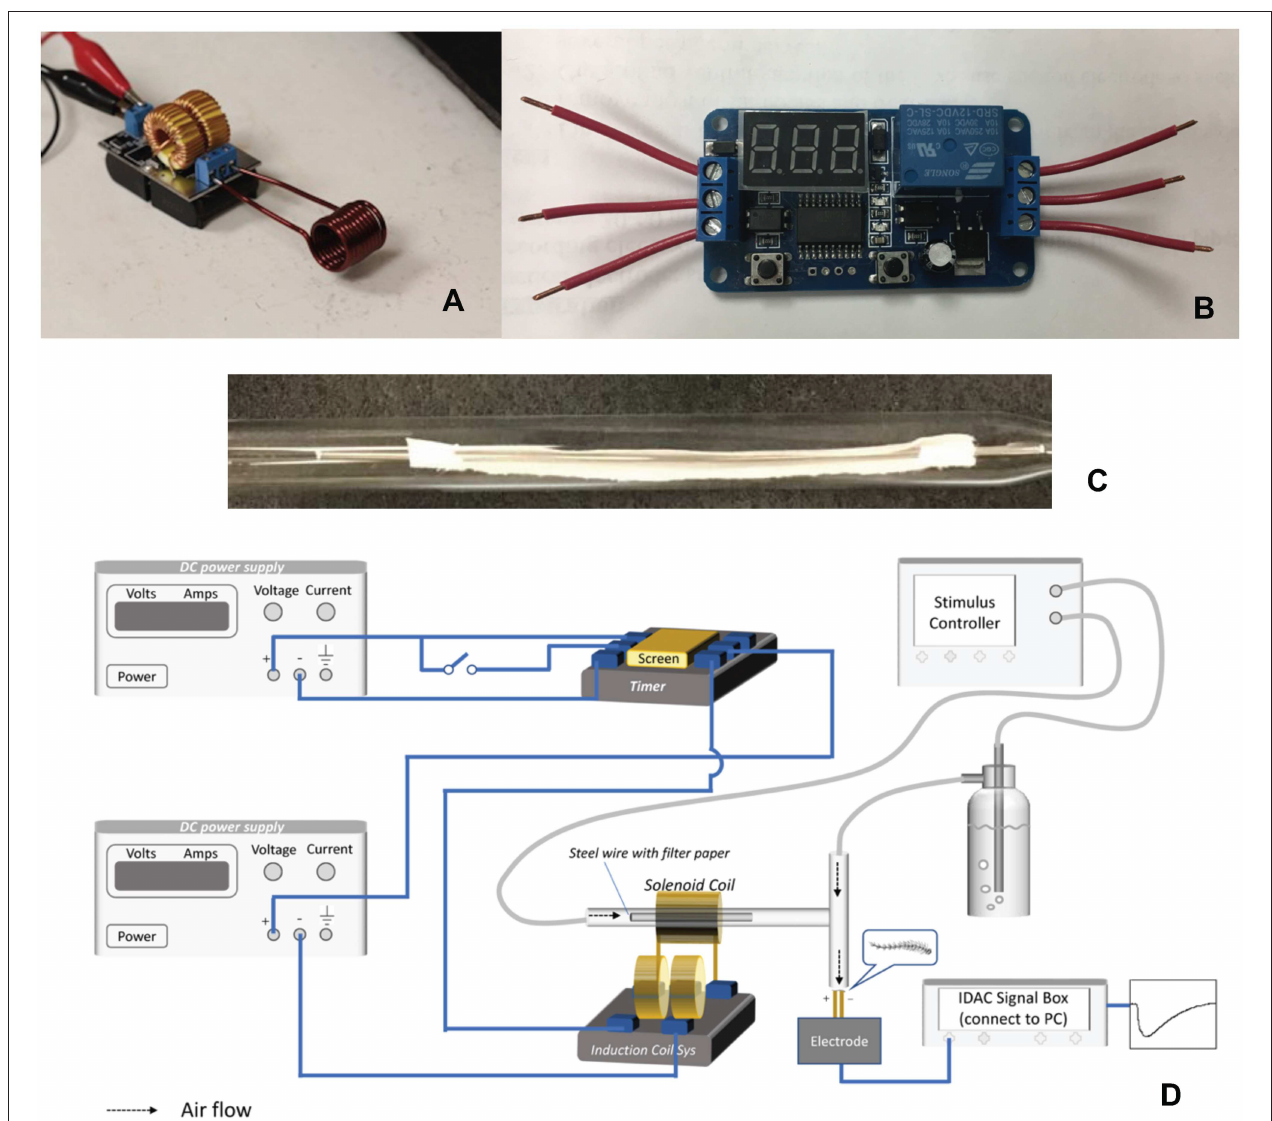
FIGURE 1 | Components of the coupled IH-EAG system. (A) The induction heating solenoid coil. (B) The digital timer. (C) Photograph of an assembled wire with filter paper within the glass pipette that is part of the air delivery tubing. (D) Diagrammatic illustration of the complete